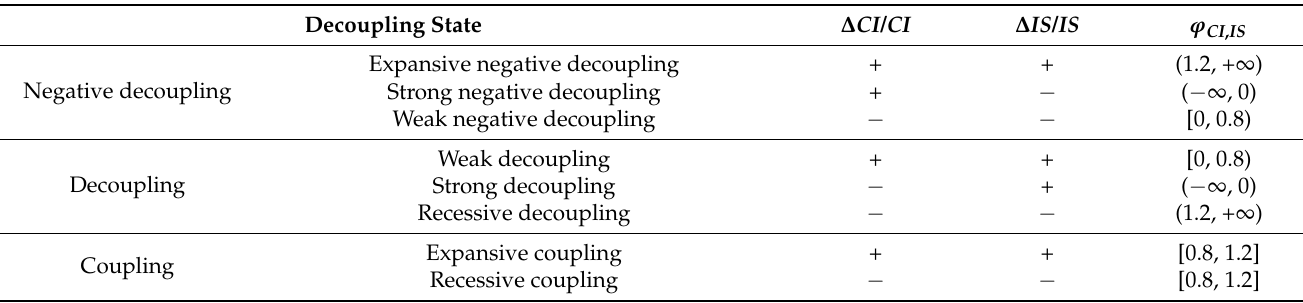
Table 2. Categorization of decoupling